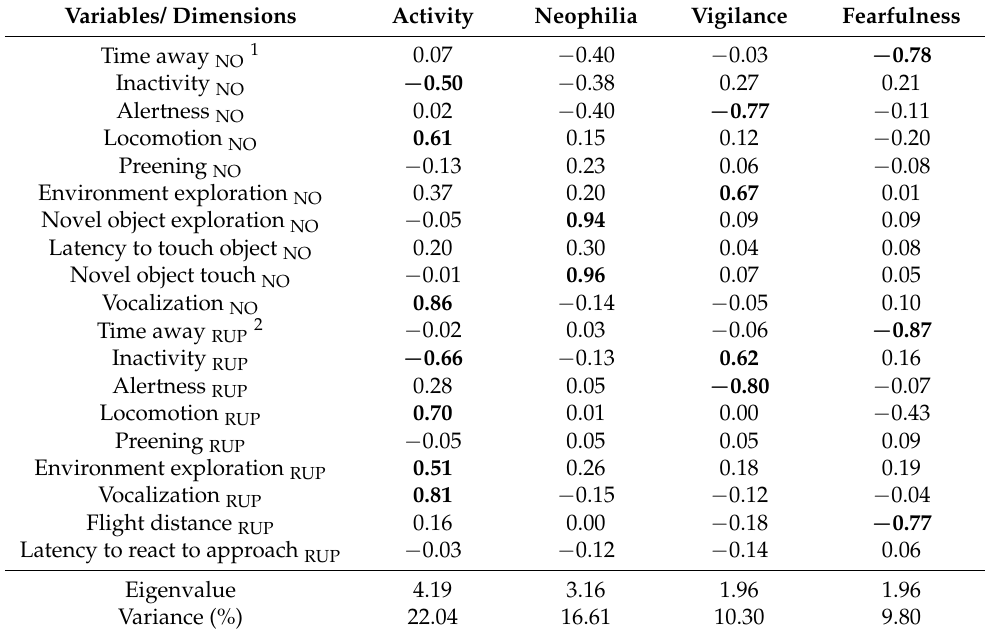
Table 2. Result of factor analysis for novel object test and the reaction-to-unknown-person test applied to 38 parrots ( A. aestiva , A. vinacea , and A. rhodocorytha ). The variables retained for the main dimensions are in bold: factor 1—activity, factor 2—neophilia, factor 3—vigilance, and factor